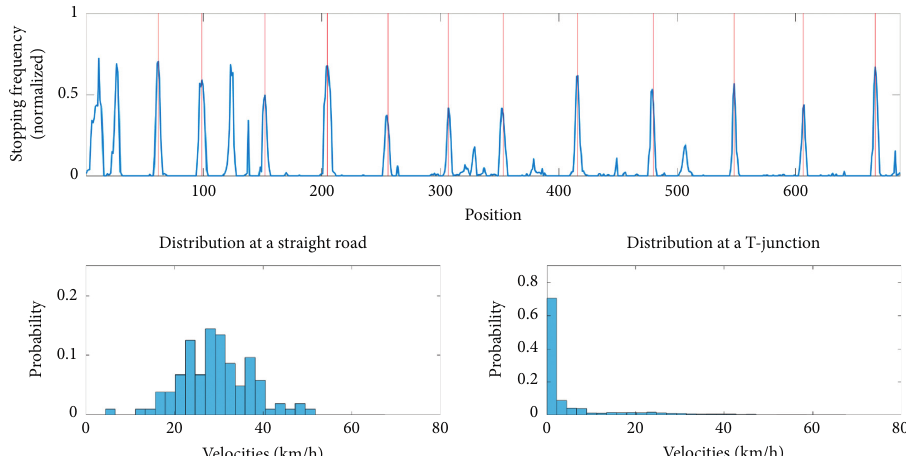
Figure 18: Graphs of normalized stopping frequency along the bus route, and velocity distributions of two different positions on the road. These graphs are derived after the filtering process as described. Red lines on the graph are the sites where there are bus